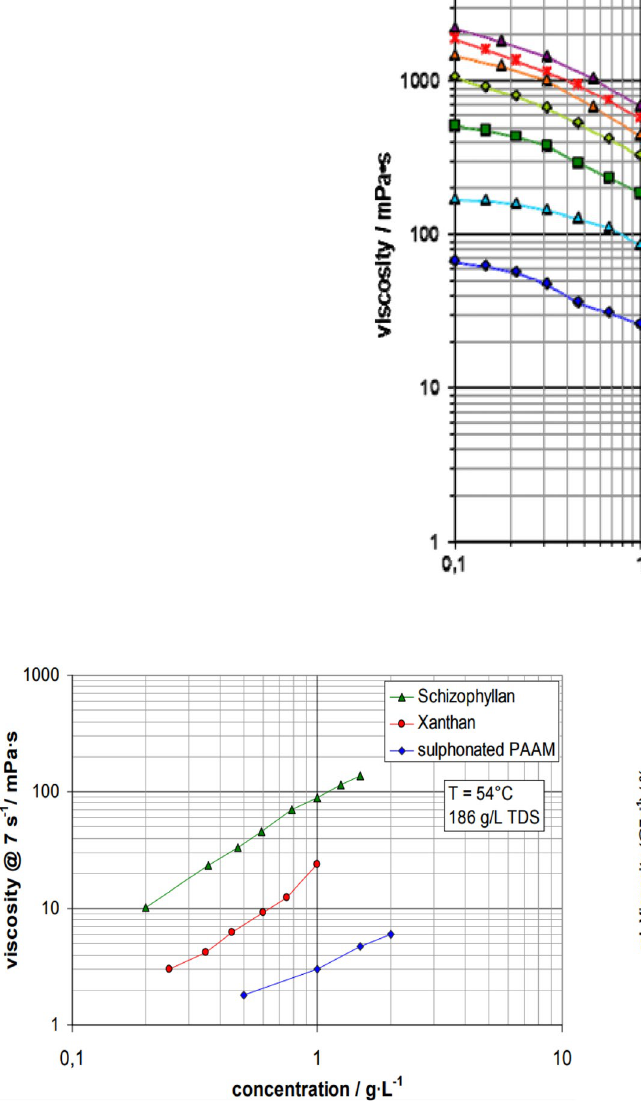
Fig. 5 Comparison of the mechanical stability of schizophyllan with commercial EOR polymers (Hatscher